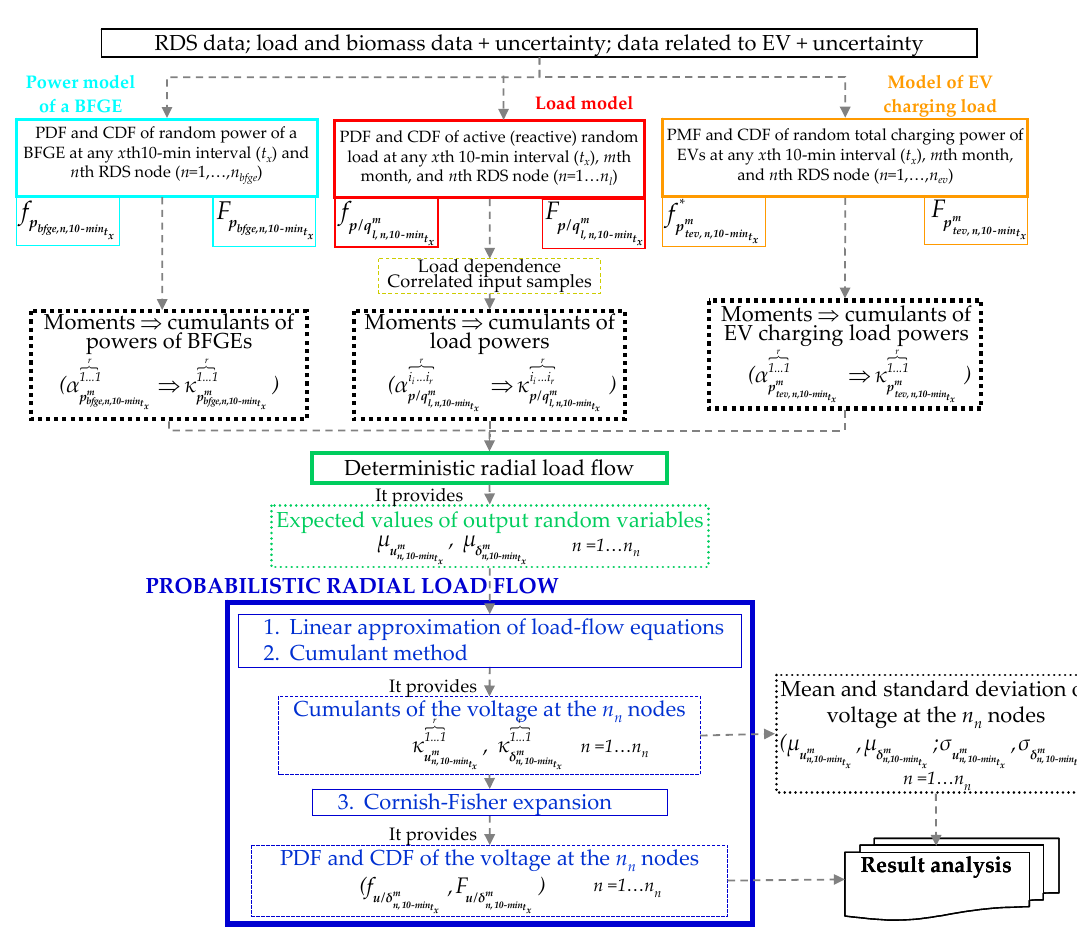
Figure 2. Flowchart of the PAT to assess the impact of BFGEs and EVs on RDSs.